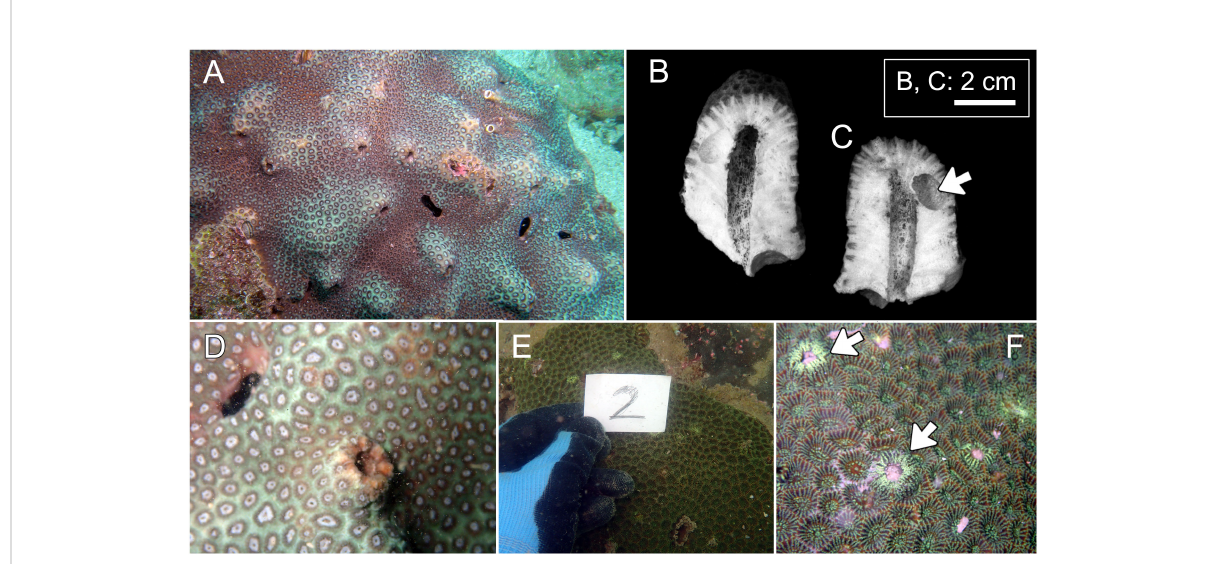
FIGURE 4 Hosts of Lithoscaptus doughnut sp. nov. (A – D) and Xynomaia species (E, F) . (A) Plesiastrea peroni , Basalt Island; (B) Plesiastrea peroni , Long Ke Tsai. (E, F) Coelastrea aspera , Pak Lap Tsai. Cross section of domicile of L. doughnut sp. nov. (B, C) with arrow showing domicile of Lithophaga sp. The “ 2 ” shown in (E) refers to number of fi eld image. Arrow on (F) showing domicile openings of Xyomaia